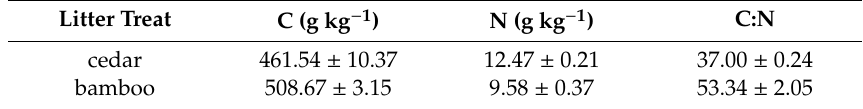
Table 1. Carbon (C), nitrogen (N), and phosphorus (P) concentration (g kg − 1 ) and their stoichiometric characteristics of cedar and bamboo fine root litter used in this